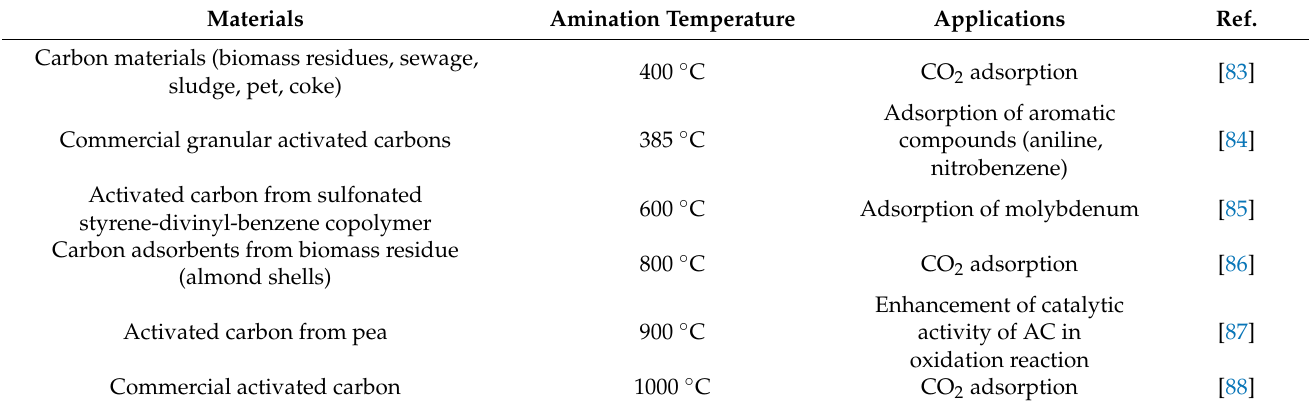
Table 3. A review of studies regarding the use of gaseous ammonia to modify activated carbon.